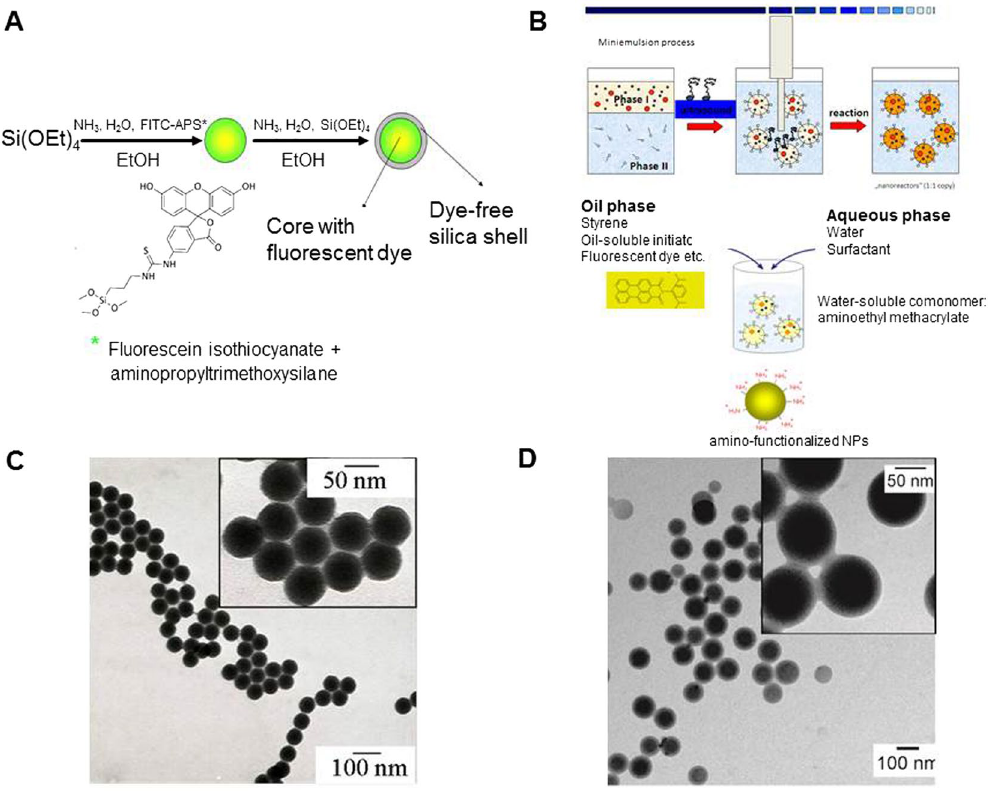
Figure 1. Features of the NPs used in this study. ( A ) Scheme of the synthesis route of the fluorescein isothiocyanate (FITC) labeled SiO 2 NPs coated with a dye-free SiO 2 shell (SiO2/FITC NPs). ( B ) Schematic illustration of the synthesis of the polymer NPs, synthesized via miniemulsion synthesis. ( C )